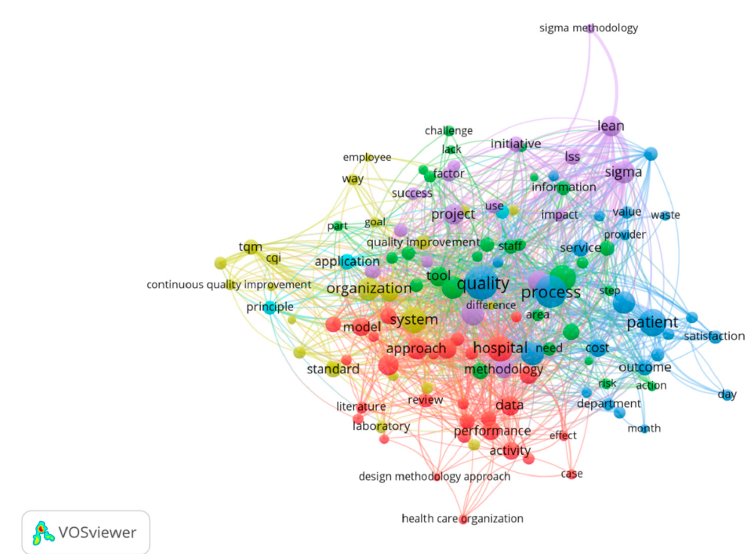
Figure 2. Word network in medical scientific publication content.